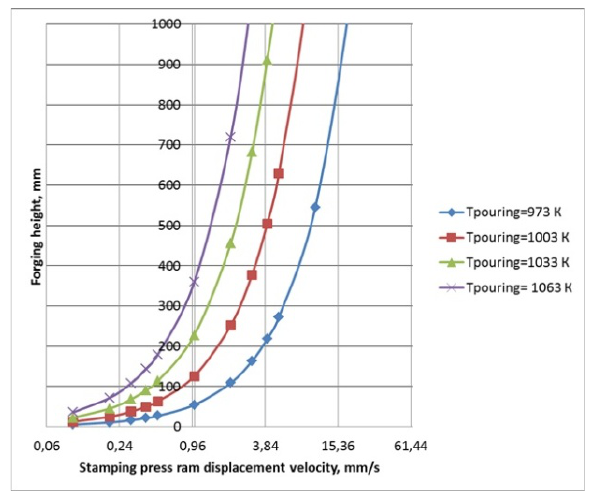
Fig. 5. Influence of the slider movement speed on the forging wall height at different filling